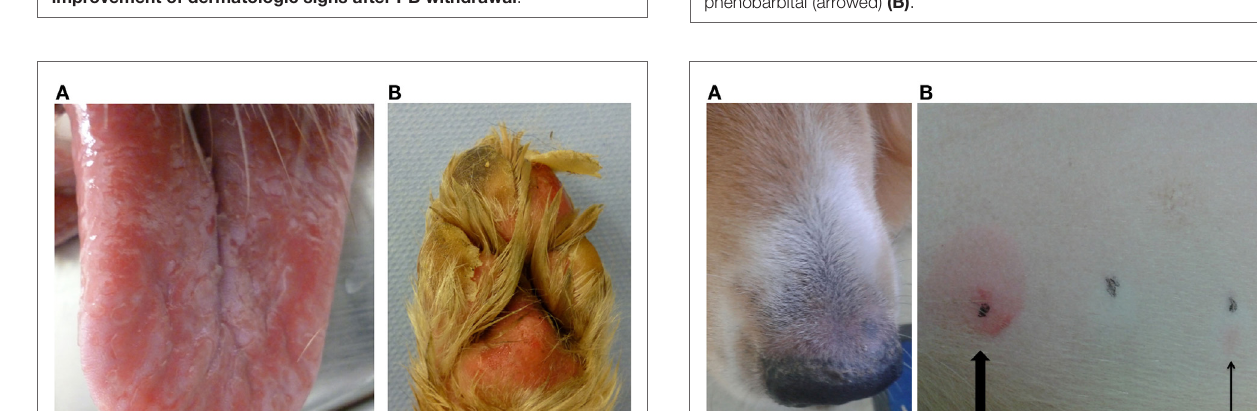
FigUre 1 | Dog P7 (mixed-breed, male-neutered, 8 years) developed a generalized, erosive-crusty dermatitis, especially in the face (a) and in the axiallry region (B) several weeks after initiation of PB; clear improvement of dermatologic signs after PB withdrawal